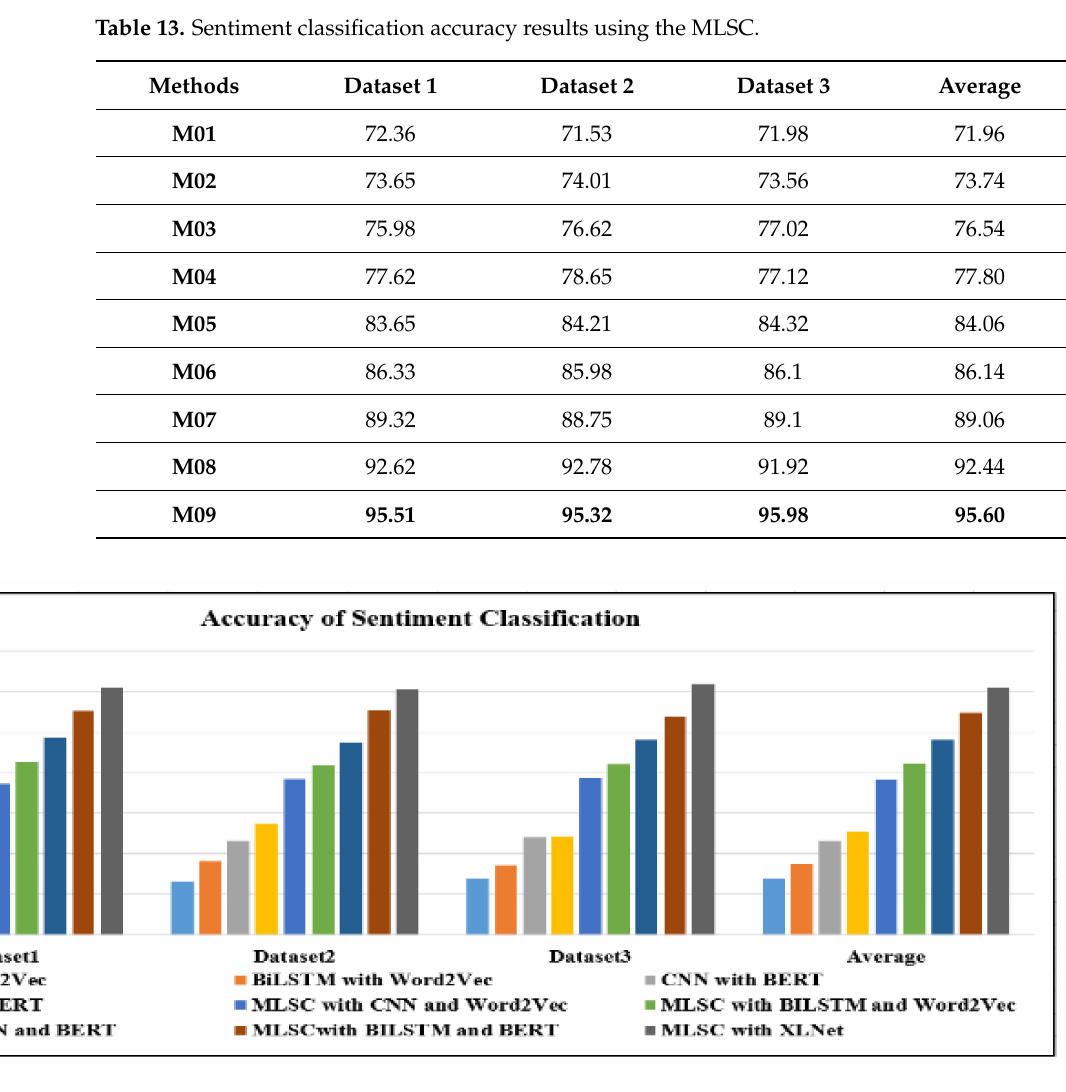
Figure 6. Graphical representation of the performance results with the